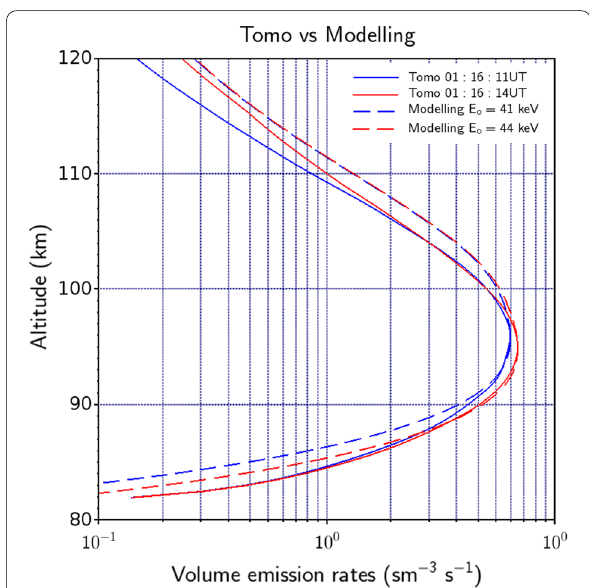
Fig. 4 The 557.7 reconstructed (solid line) and calculated (dashed line) emission rate